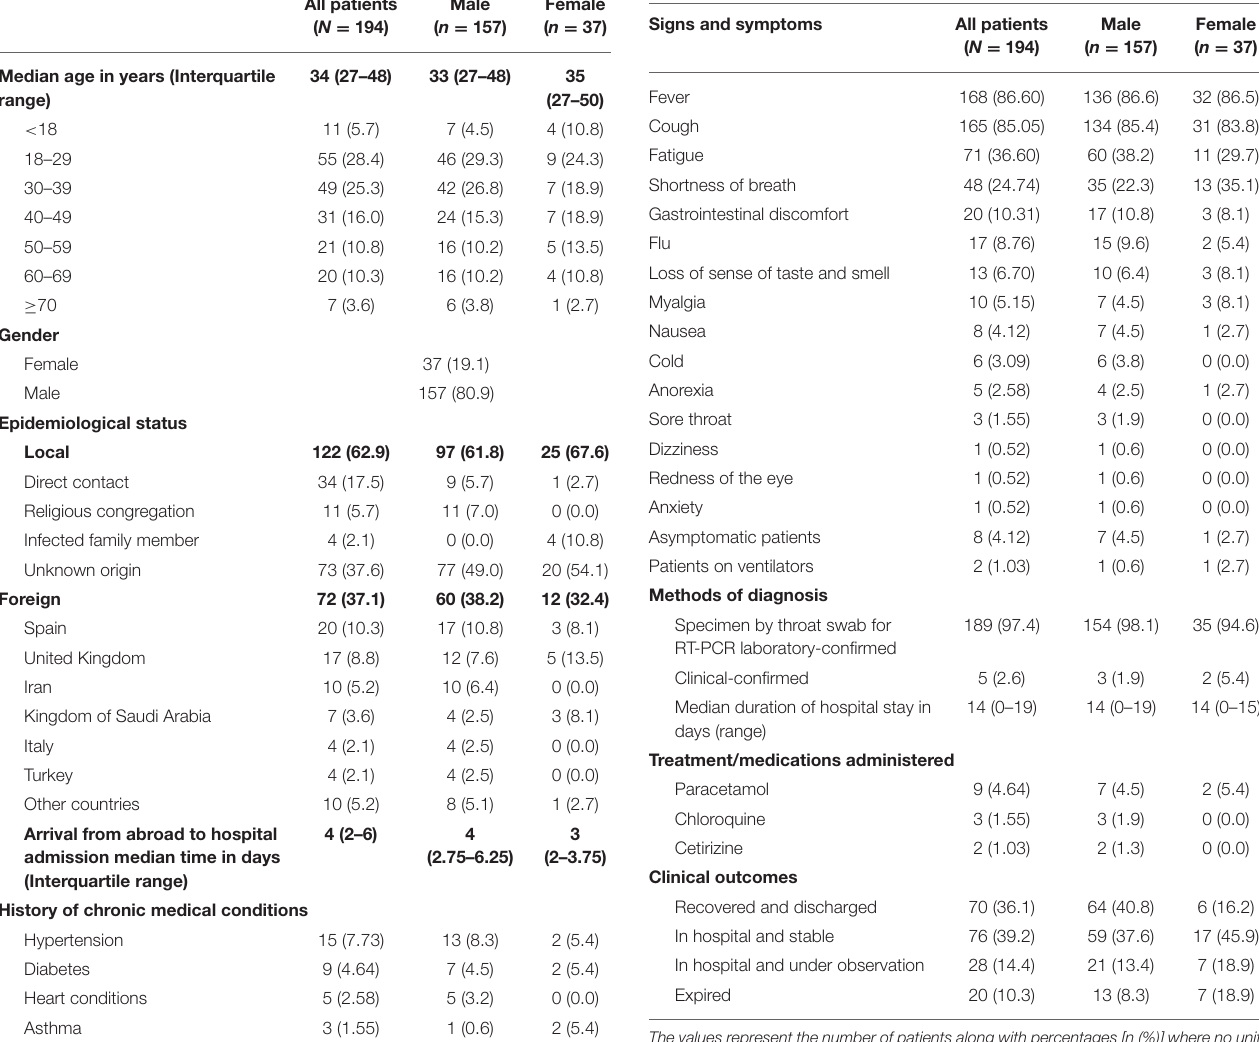
All patients ( N = 194)